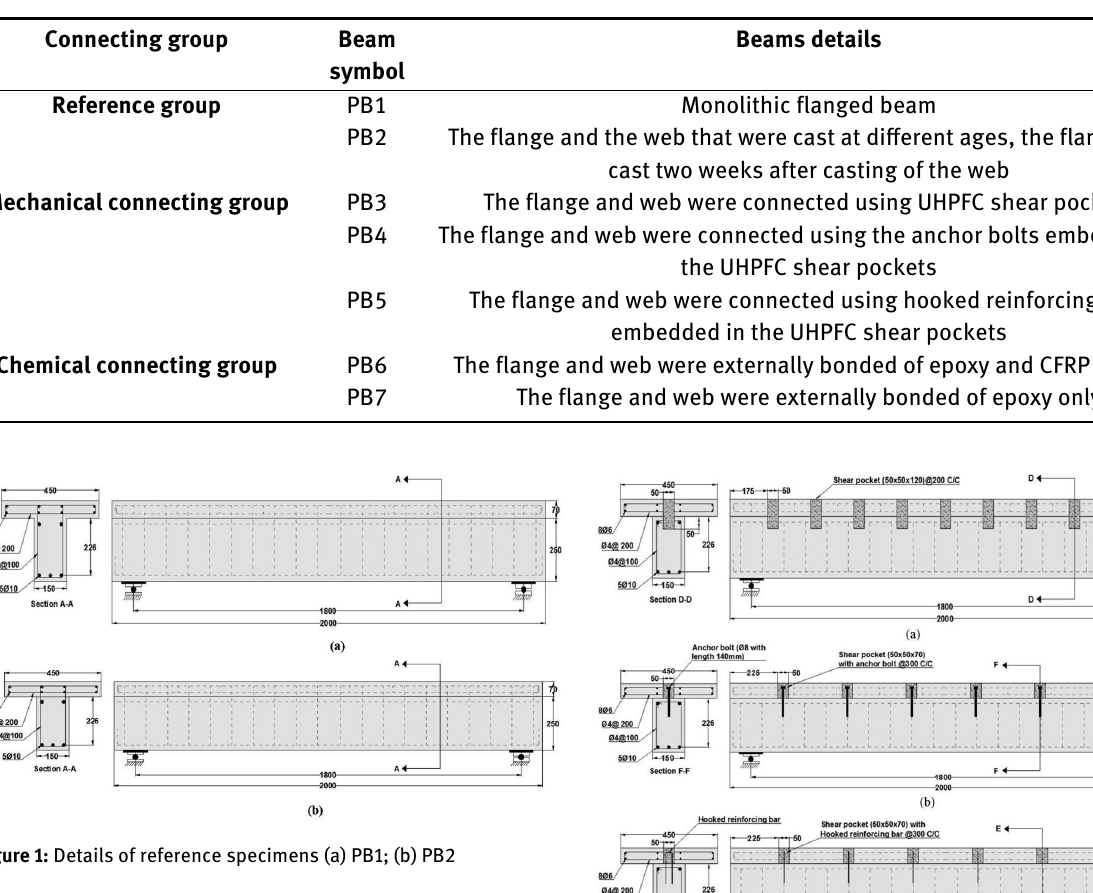
Table 1: Details of tested composite beams